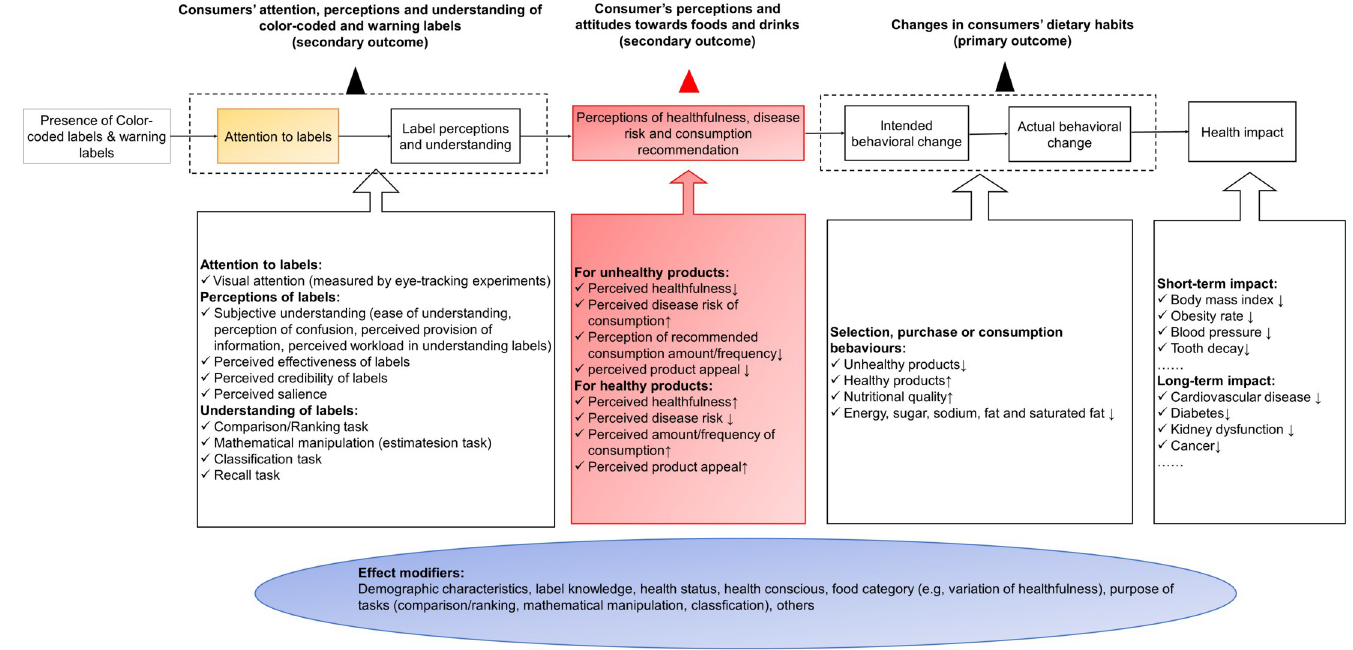
Fig 1. The logic model of the impact of colour-coded labels and warning labels on consumers’ behaviour based on the health communication theory. Attention to labels is a prerequisite for understanding of labels and forming perception towards labels (amber box), but the mechanisms connecting changes in label understanding and perception with behavioural changes differ across FOPL types. Warning labels (e.g., NW and HW) elicit negative perception of food products (e.g., perception of severe risk, negative emotion) in motivating changes in food choice, while interpretive colour-coded labels (e.g., TLS and NS) improve the perception of healthfulness for healthier food options (red box). Demographic characteristics, knowledge of labels, nutrition and health, food categories, and experiment settings also modify the effects of FOPLs throughout the mechanism (blue box). FOPL AU : AbbreviationlistshavebeencompiledforthoseusedinFigs 1 (cid:0) 6 : Pleaseverifythatallentriesarecorrect : , front-of-package nutrition labelling; HW, health warning; NS, Nutri-Score; NW, nutrient warning; TLS, traffic light labelling